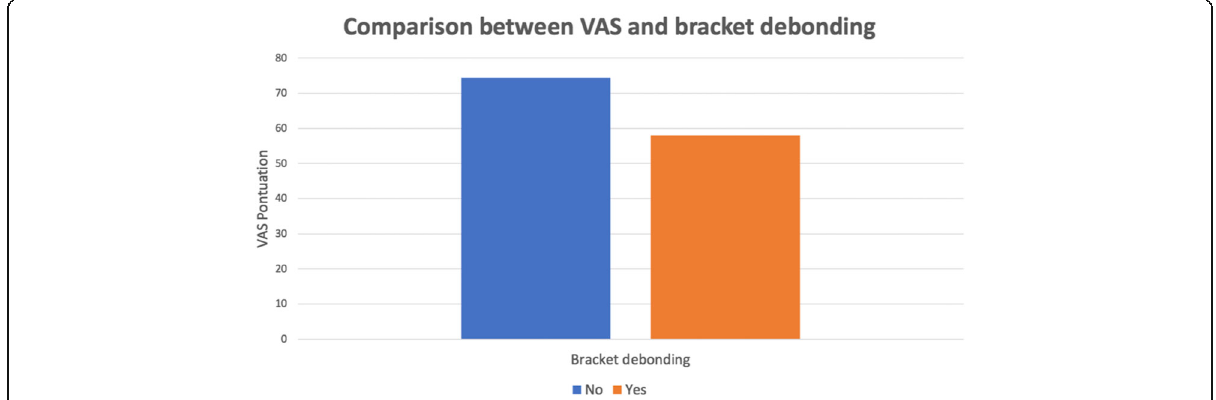
Fig. 1 Comparison between patient self-report of treatment cooperation (VAS) and bracket debonding ( p ≤ 0.001)